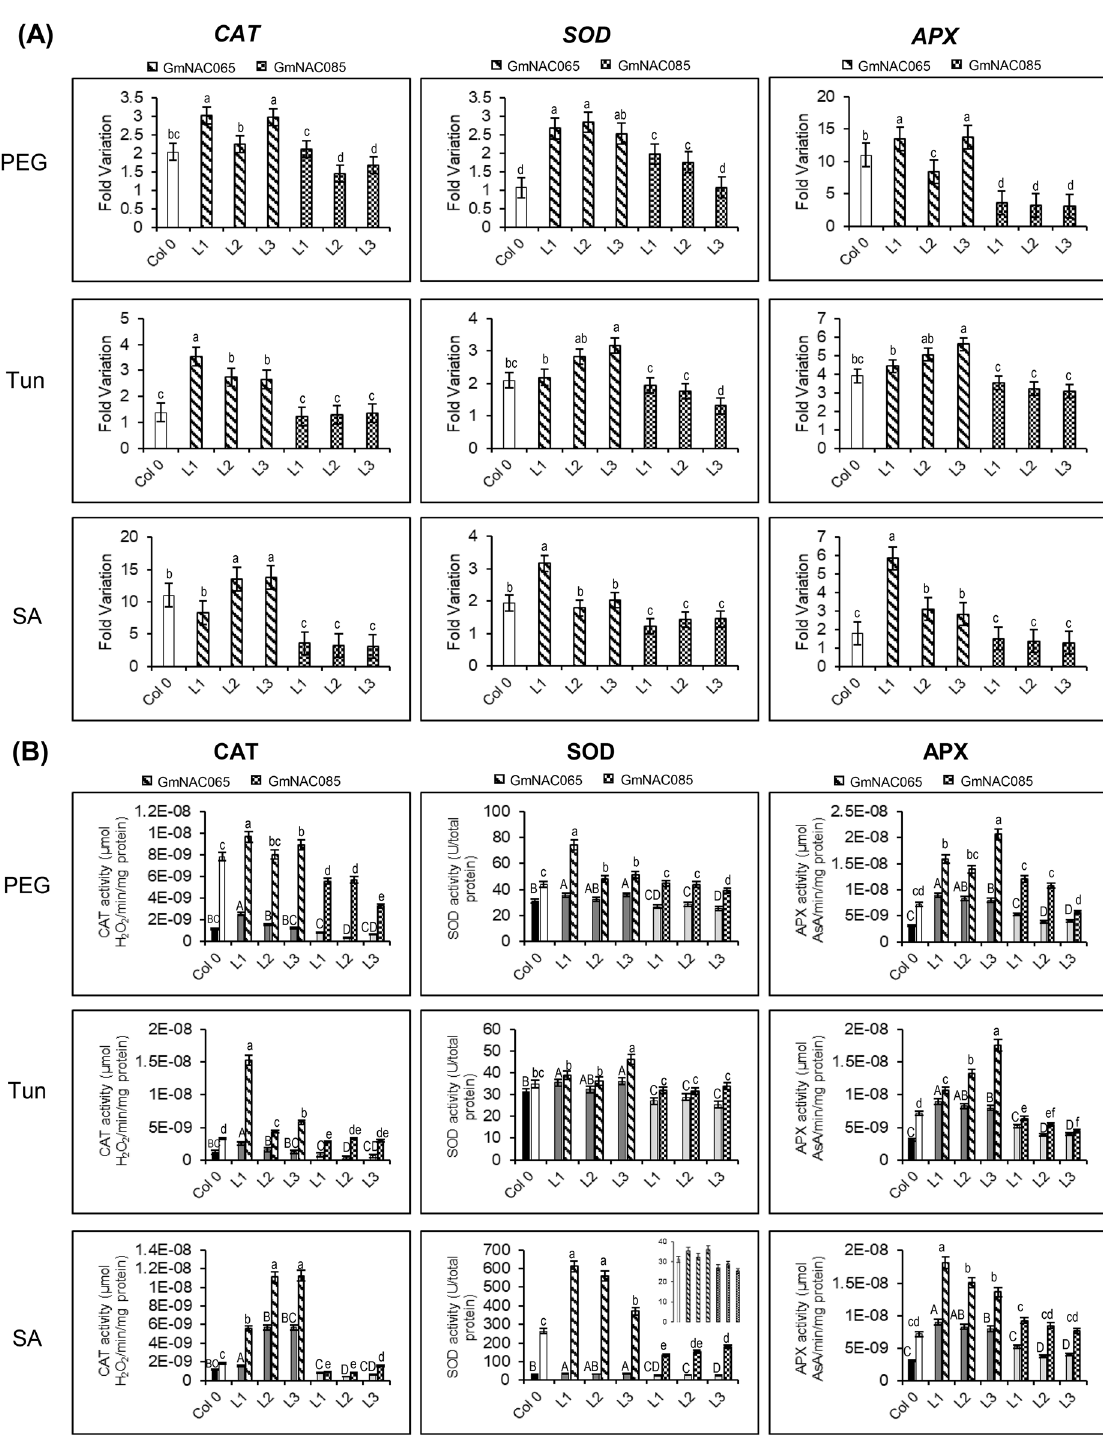
Figure 6. Expression profiles and activities of antioxidant enzymes catalase (CAT), superoxide dismutase (SOD), and ascorbate peroxidase (APX) in GmNAC065-OX and GmNAC085-OX lines under different stress conditions. ( A ) Expression profile of CAT, SOD, and APX in transgenic Arabidopsis lines after 24 h of stresses. Fold variation data were normalized according to the expression levels of the control samples (FV = 1.0). ( B ) Enzymatic activity of CAT, SOD, and APX in GmNAC065-OX and GmNAC085-OX plants under different stresses. Drought, ER stress, and biotic stress were simulated by PEG 8000—10% w/v; Tun—5 µg/mL; and SA—75 µM treatments, respectively. Solid bars show data from untreated plants. Upper bars indicate standard error (95% of confidence). Uppercase letters indicate significant differences among control samples, and lowercase letters indicate significant differences among treated samples by the Tukey’s test (p < 0.05, n =